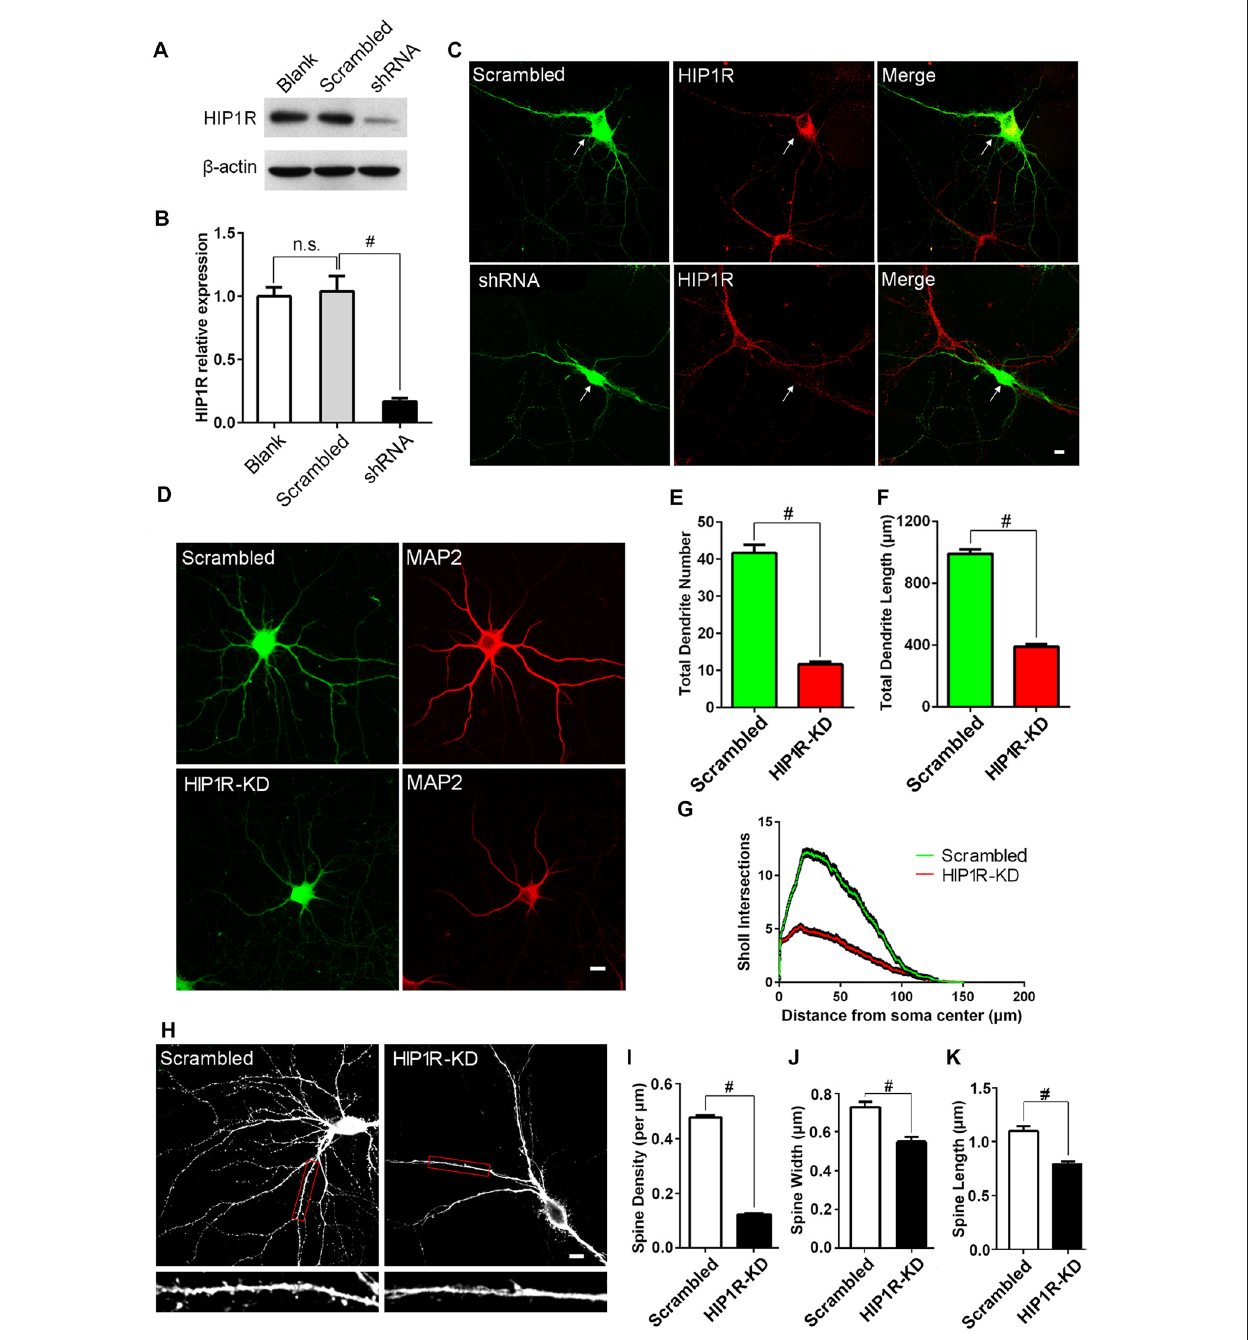
FIGURE 2 | Knockdown of HIP1R expression suppresses dendrite growth and spine formation. (A) Cultured hippocampal neurons were infected by HIP1R-shRNA or scrambled control lentivirus and harvested for western blotting at DIV13. A representative western blot shows that the expression level of HIP1R was dramatically reduced in the shRNA group (shRNA) compared to the scrambled control (Scrambled), and viral infection itself had no effect on HIP1R expression (Blank). (B) Densitometric analysis of western blotting from 4 independent experiments; Blank, 1.00 ± 0.07; Scrambled, 1.04 ± 0.12; shRNA, 0.17 ± 0.03. (C) Cultured hippocampal neurons were transfected at DIV6 with HIP1R-shRNA or scrambled plasmid vectors. Immunofluorescence staining at DIV13 showed a significant decrease in HIPIR immunoreactivity in HIP1R-KD neurons (shRNA) but not in the control (Scrambled). Arrows indicate transfected neurons marked by GFP expression. Scale bar = 10 µ m. (D–G) Images of HIP1R-shRNA transfected neurons at DIV13 immunostained with anti-MAP2 and used for counting dendrites. Scale bar = 10 µ m (D) . Unpaired two-tailed t -test analysis showed a significant decrease in the total dendritic branch number and total dendritic length in the HIP1R-KD group compared to the scrambled control; 11.69 ± 0.67, n = 45 vs. 41.64 ± 2.15, n = 45 (E) and 388.98 ± 16.63 µ m, n = 45 vs. 989.91 ± 28.38 µ m,